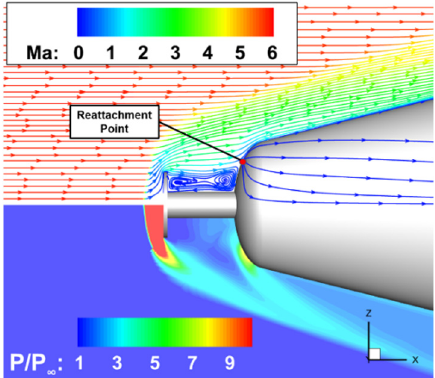
( b ) Figure 6. Comparison of γ distributions. ( a ) without aerodisk, ( b ) with 2 mm long aerodisk. Concerning the γ distribution, the transition onset is discovered at the root of the aerodisk, and the transition develops rapidly along the centerline. Figure 7 delineates the streamlines and the non-dimensional pressure ( P/P ∞ ) contours near the aerodisk in the symmetry plane. Conspicuously, owing to the existence of aerodisk, the recirculation zone with low pressure is created around the aerodisk, and the reattachment shock leads to a reattachment point lying on the shoulder of the forebody. The comparison of surface P/P ∞ and limiting surface streamlines on the nose are shown in Figure 8. Through quantitive analysis, the peak point of surface pressure is discovered a little downstream from the reattachment point. The peak pressure is reduced about 70.91% and is much lower com- pared to that without an aerodisk. Furthermore, as the reattachment shock generates the